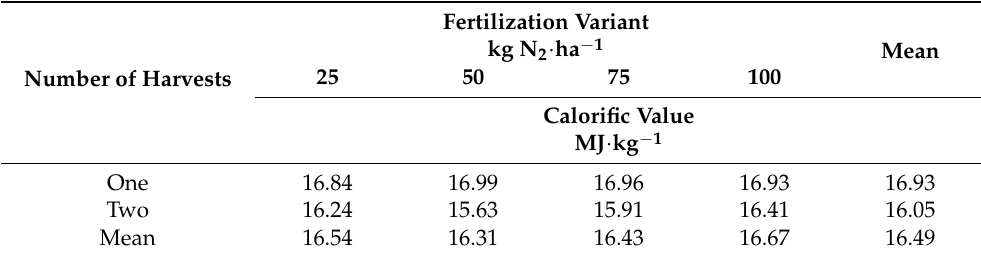
Table 12. Calorific value of Japanese knotweed depending on the number of harvests and the nitrogen fertilization variant